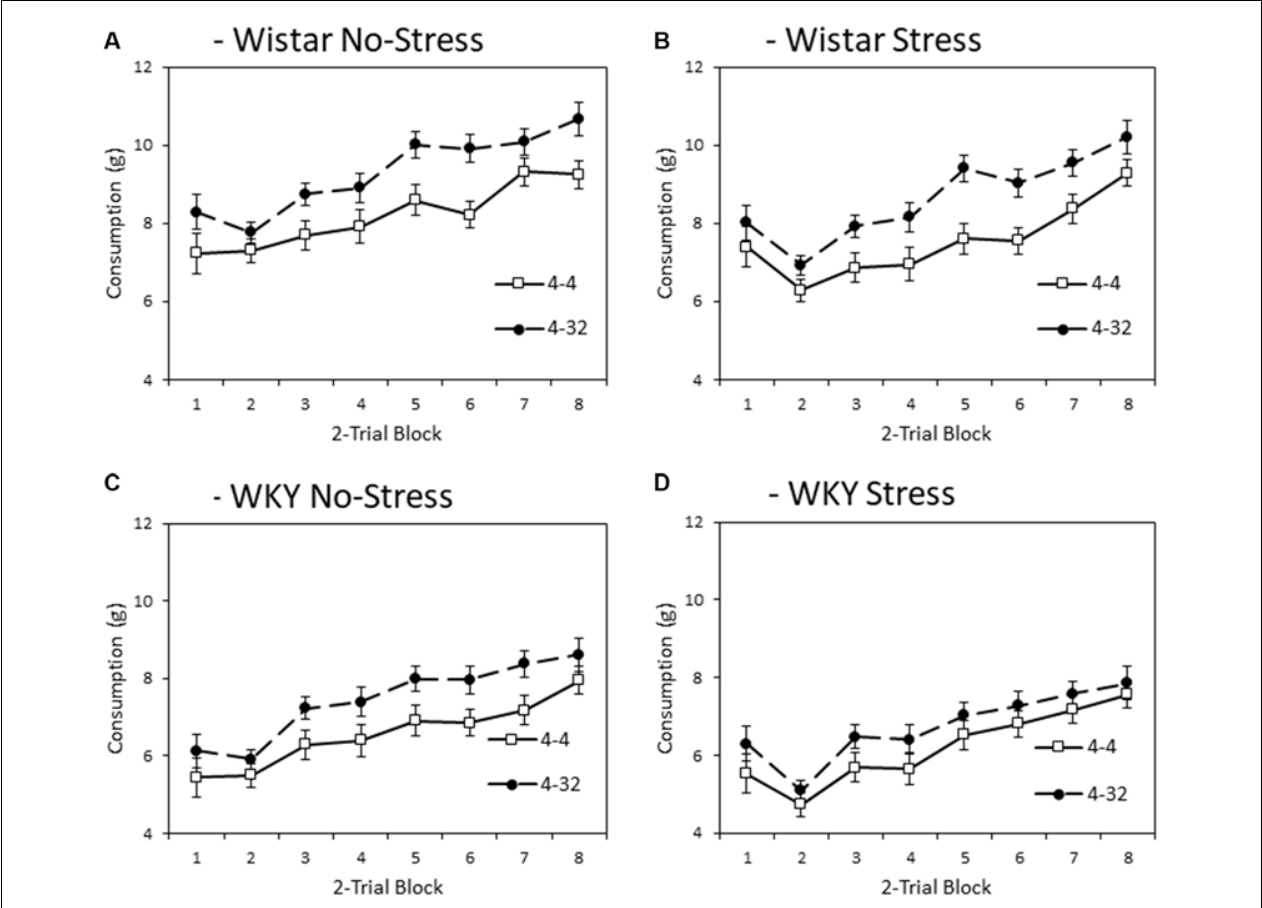
FIGURE 4 | Mean consumption ( ± SEM) of the second presentation solution made available each day as a factor of strain (Wistar: Panels A,B ; WKY: Panels C,D ) and stress (No-Stress: Panels A,C ; Stress: Panels B,D ). Open symbols represent the consumption of 4% sucrose in the second bottle and filled symbols represent the consumption of 32% sucrose in the second bottle. Data presented is averaged across 2-session blocks. Solutions in the second bottle were made available for 6 min. WKY rats consumed significantly less than Wistar rats, and stressed rats consumed significantly less than no-stress rats, but these effects did not interact. Also, consumption of 32% sucrose was higher than that of 4% sucrose, but this difference was not significantly influenced by strain or stress (see “Second Solution Consumption—Low vs. High Sucrose Concentration” section for details).